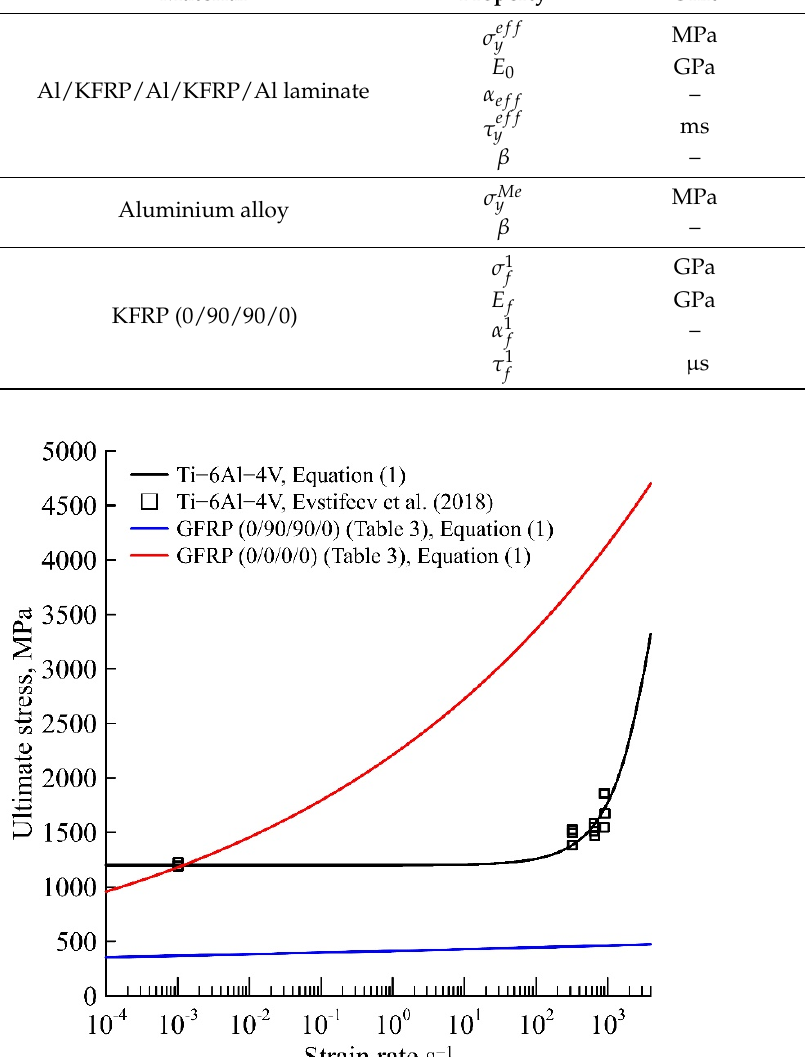
Figure 5. Comparison of strain rate dependencies of Ti-6Al-4V [47] and strain rate dependencies of the polymer fibre/epoxy (0/90/90/0) and (0/0/0/0) strength in Table 3.